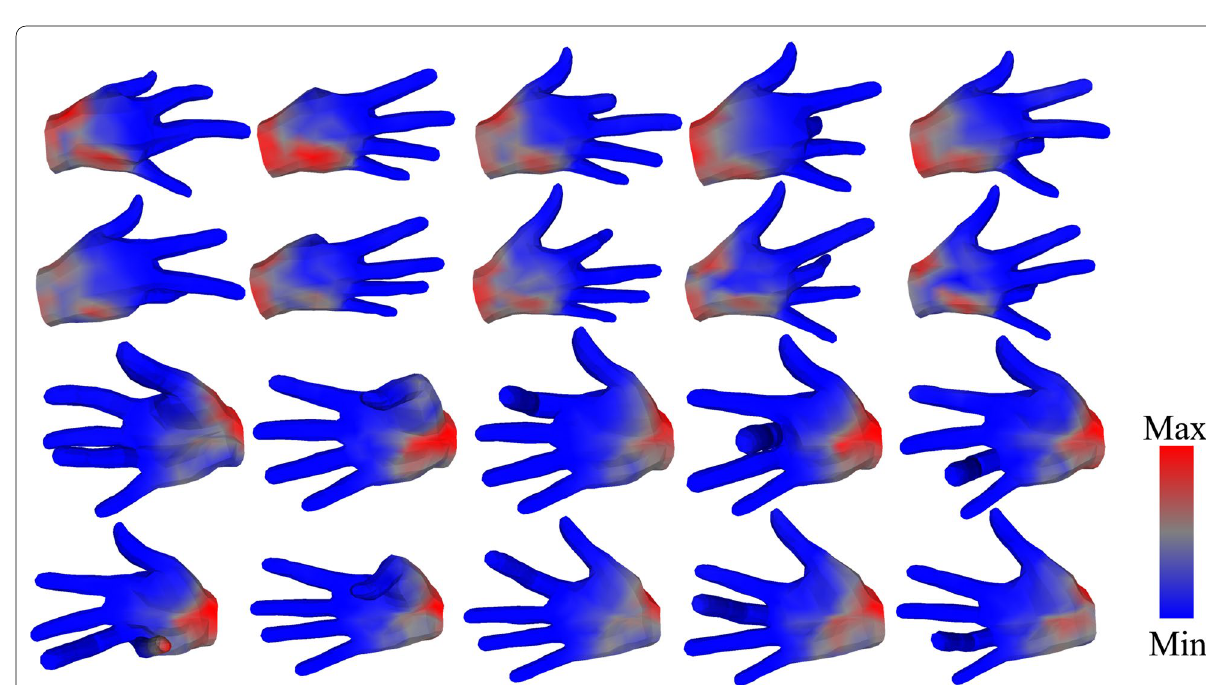
Fig. 11 Colormaps of per vertex Euclidean modication produced on Hand